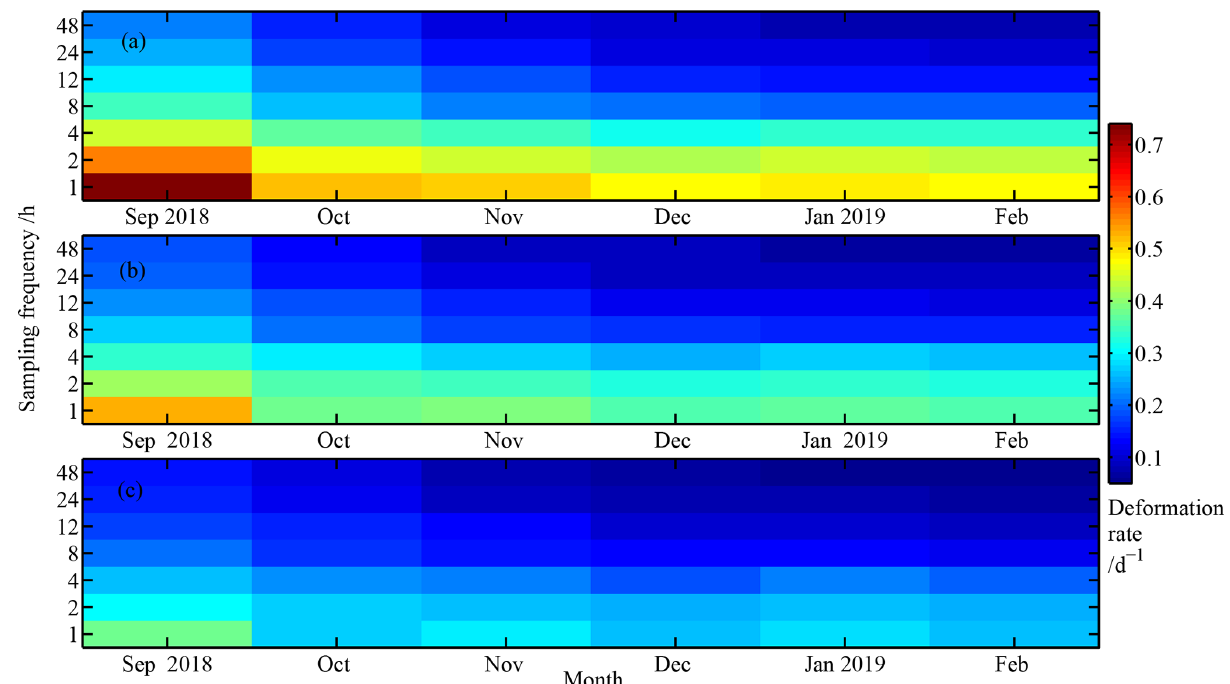
Figure 12. Monthly average sea ice deformation rate calculated from the CHINARE buoy cluster at length scales of (a) 7.5km, (b) 15km, and (c) 30km using position data resampled at various intervals between 1 and 48h.